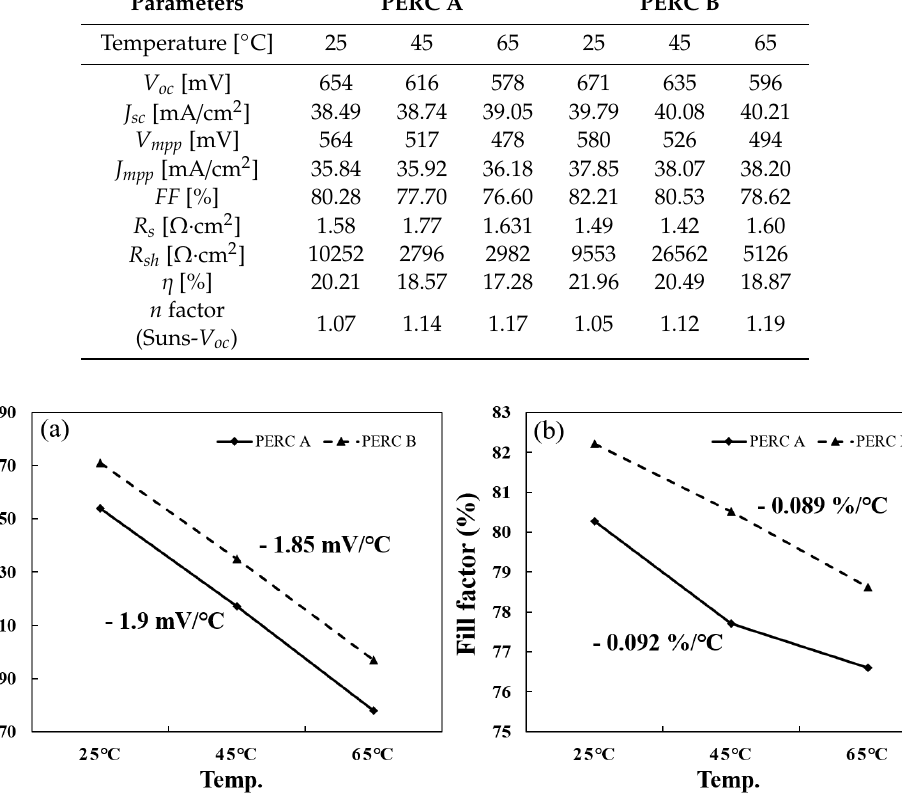
Figure 4. Temperature coe ffi cient of ( a ) V oc and ( b ) fill